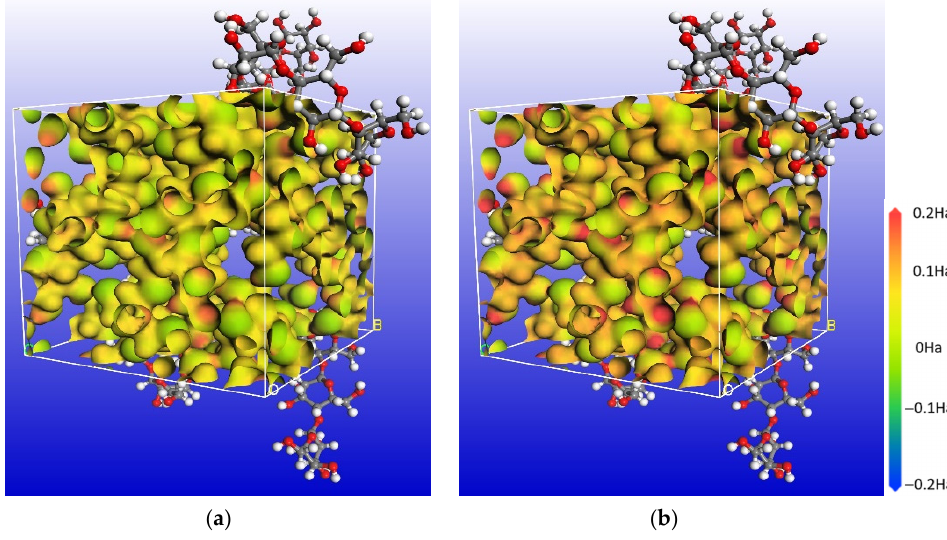
Figure 19. Electrostatic potential of two cellulose models: ( a ) Cellulose model; ( b ) Cellulose model with 3.5% water.